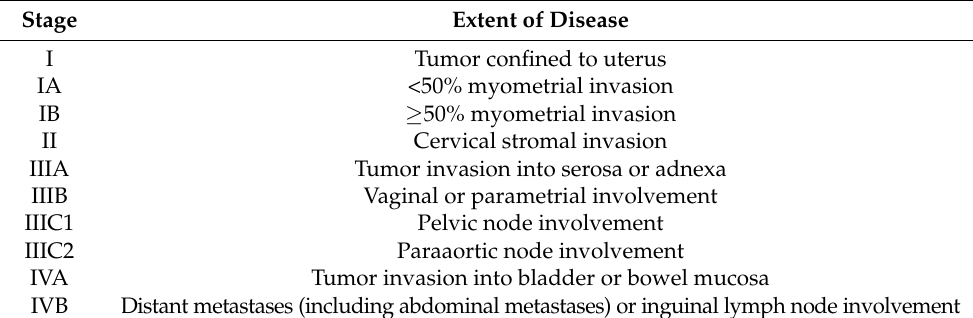
Table 10. 2009 FIGO staging for endometrial cancer.